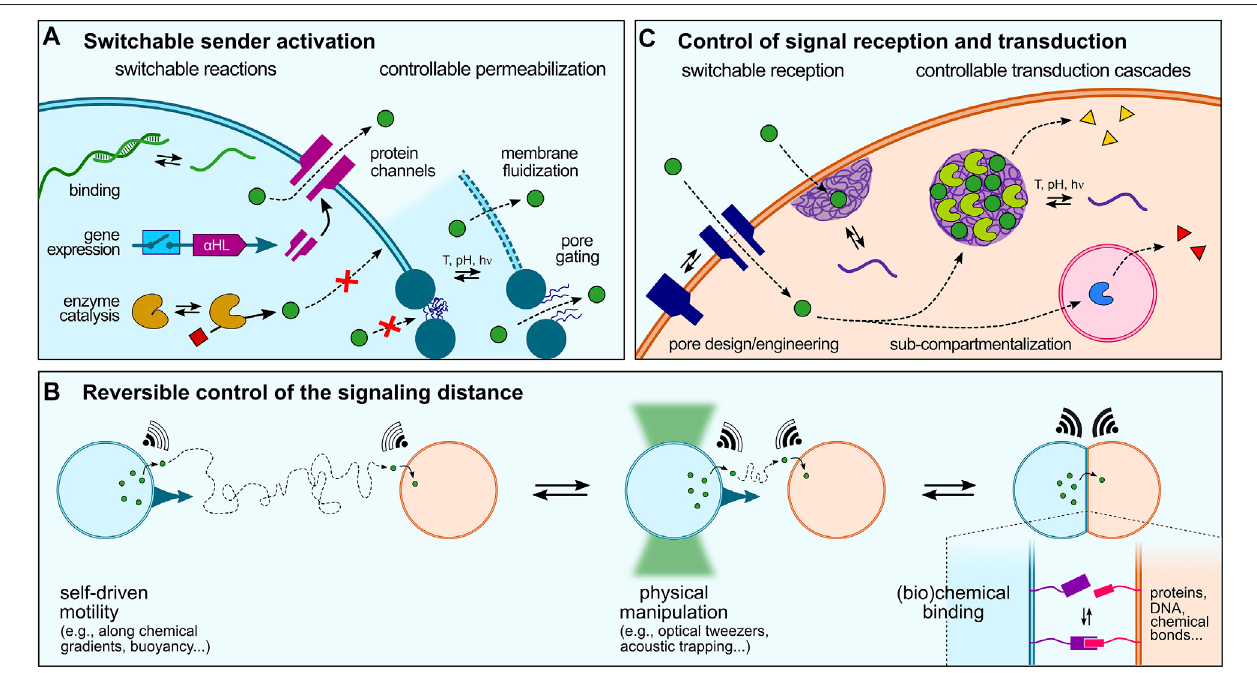
FIGURE 3 | Dynamic control over arti fi cial cell signaling. (A) Various strategies can be implemented to regulate signal production or release that can be schematicallysplitintwocategories:switchablereactions,suchassequence-speci fi cssDNAbindingandrelease,switchablegeneexpression(e.g.,usingriboswitches), oractivationofenzymereactions,andcontrollablepermeabilization,viagene-directed insitu synthesisofproteinpores,membrane fl uidizationandformationofdefectsin continuous lipid- or polymer-based membranes, or pore gating in discontinuous membranes. (B) Reversible modulation of arti fi cial cell-cell communication could alsobeachievedbydynamicallychangingthedistancebetweensenderandreceivercell,e.g.usingphysicalmanipulationorchemicalbindingstrategies,orbyexploiting the motilityof arti fi cial cells. (C) Signal reception and transduction withinreceiver cells can last be regulated by switchable reception, e.g., using stimuli-responsivepores or strategies to enhanced signal transduction across membranes such as membrane-addressed coacervates, and programmable transduction pathways, e.g. using speci fi c addressing into